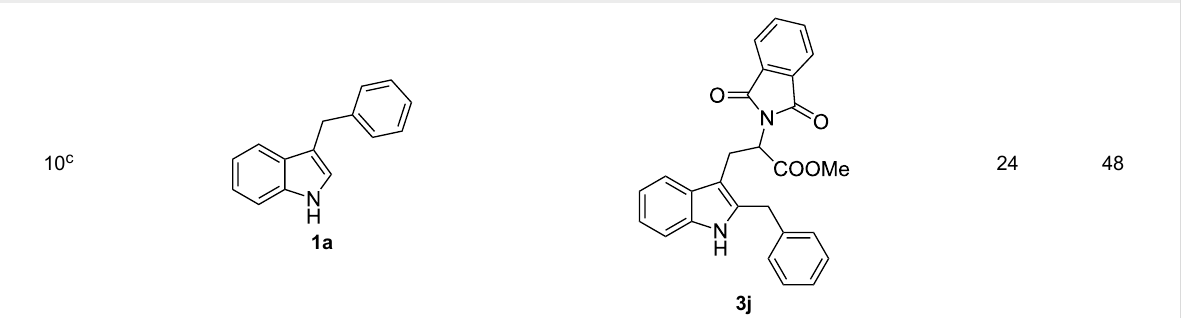
Table 2: Synthesis of 2-benzyltryptophans 3a–j . a (continued)